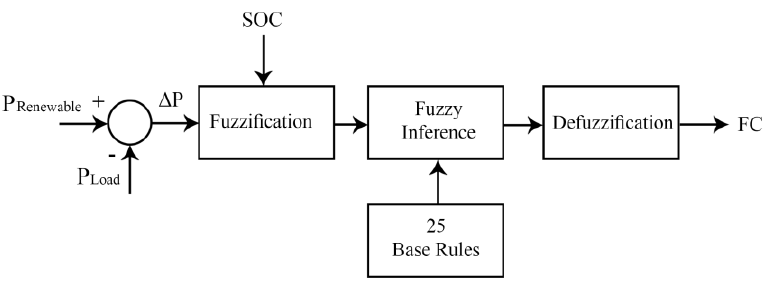
Figure 4. Fuzzy logic controller structure of the energy management system (EMS).